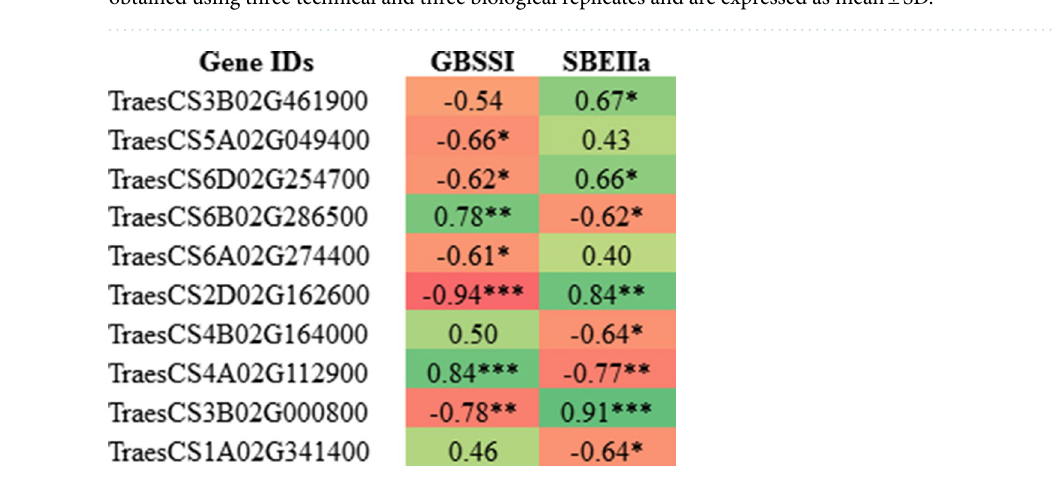
Figure 9. Pair wise Pearson’s correlation analysis of 10 RING protein genes with two starch pathway genes GBSSI and SBEIIa . The significant values of correlation coefficient (r) labeled with *p ≤ 0. 05, **p ≤ 0. 01 and ***p ≤ 0.